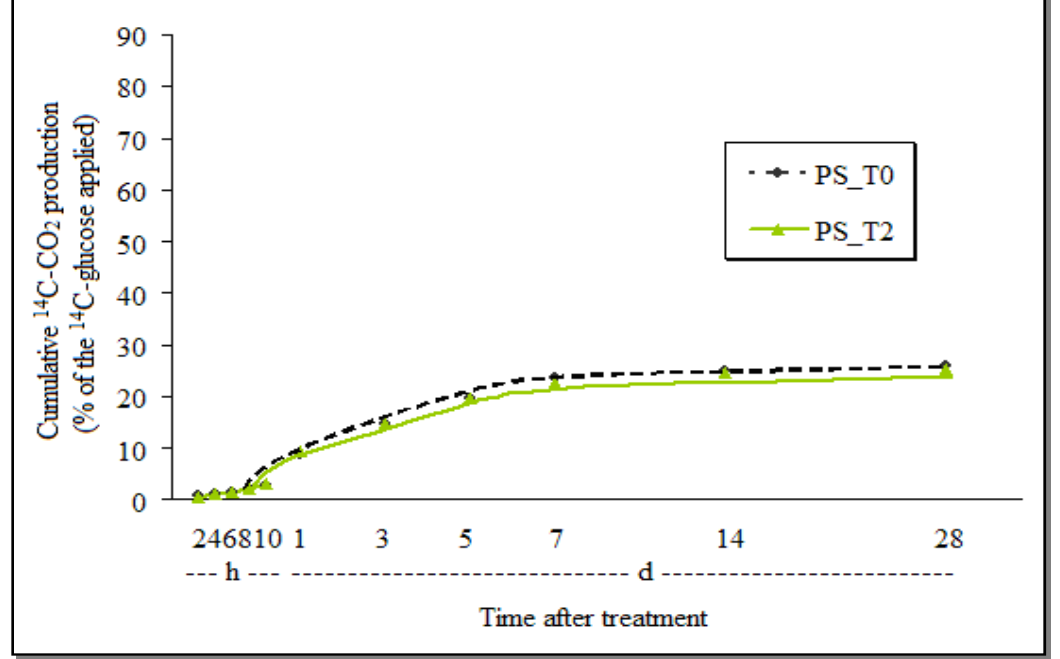
Figure 3. Cumulative production of 14 C-CO with the P. sonchifolia methanol fraction (PS_T0 = control; PS_T2 = P. sonchifolia ; h = hours; d = days) extract.